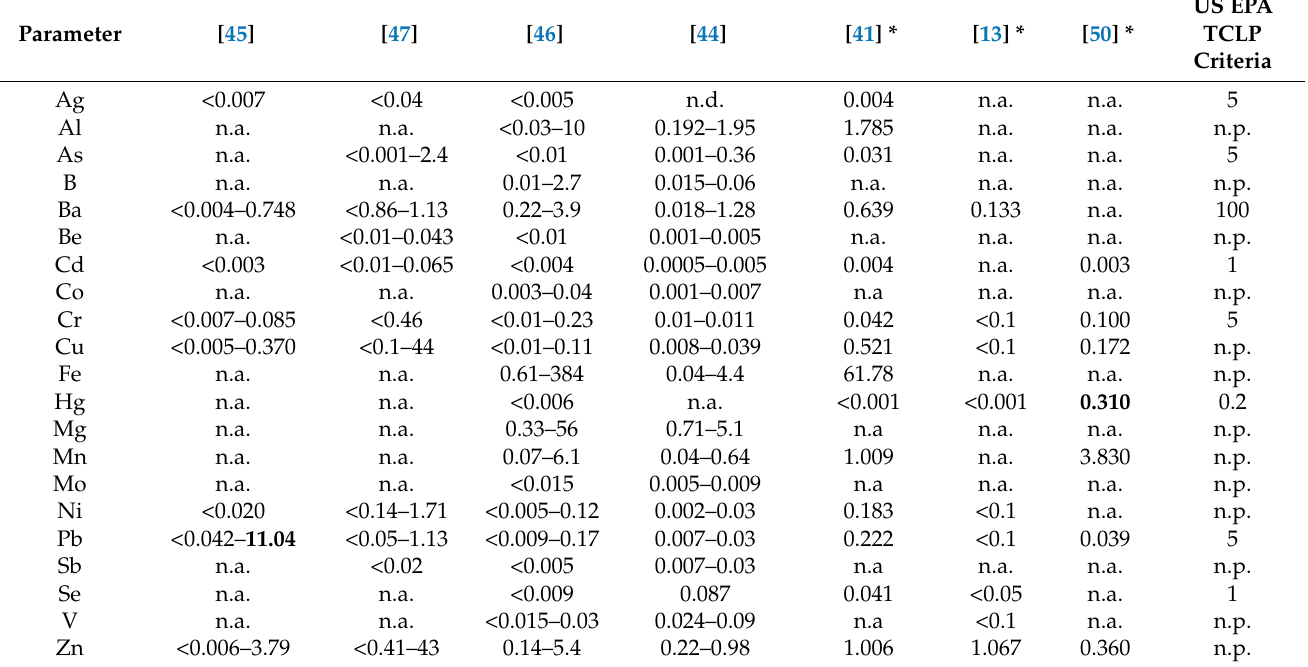
Table 4. Results of leaching test carried out on WFS according to TCLP